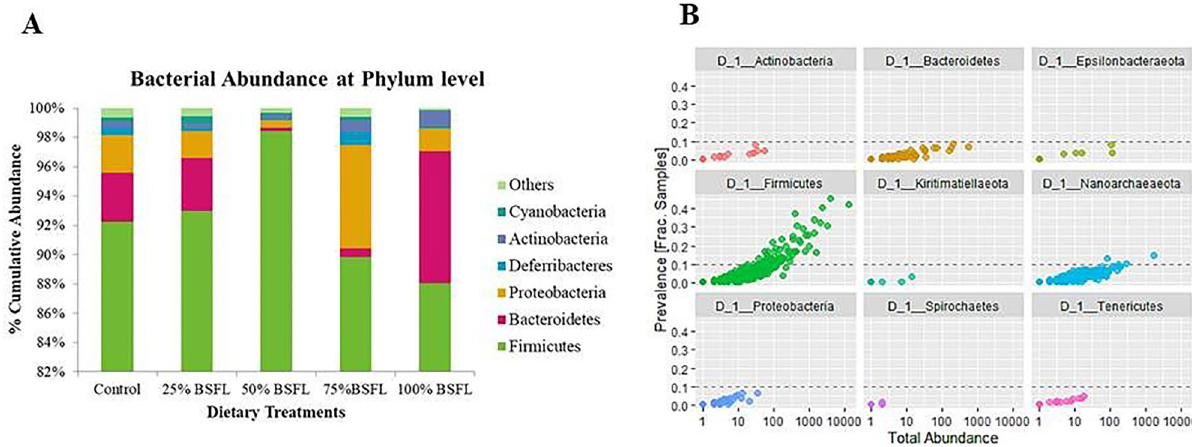
Figure 1. A stacked bar chart showing ( A ) Cumulative taxonomic composition at Phylum level; and ( B ) Prevalence of all observed phyla taxa in gut profiles of layers fed black soldier fly larvae